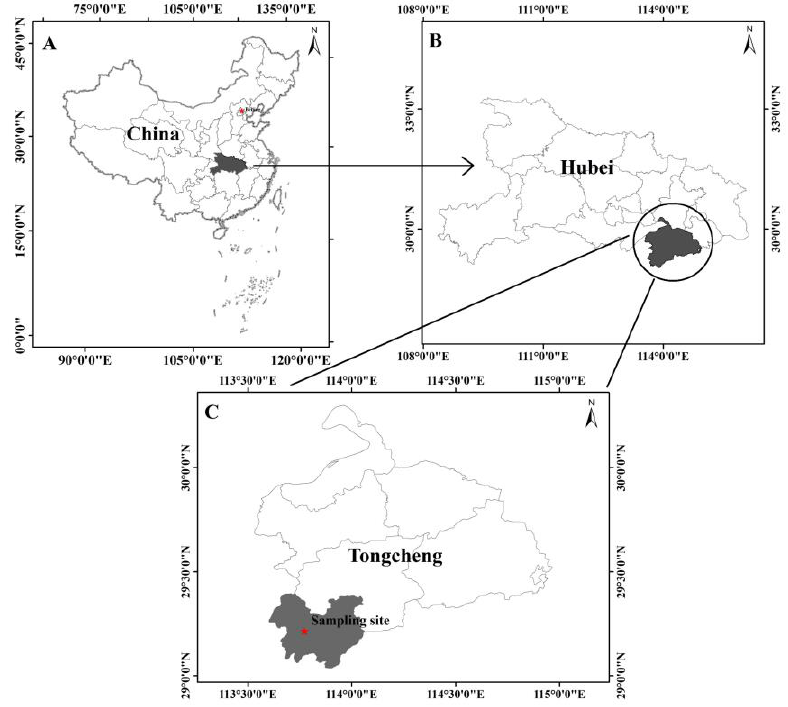
Figure 2. Location of sampling site in Tongcheng County ( C ), Hubei Province ( B ), China ( A